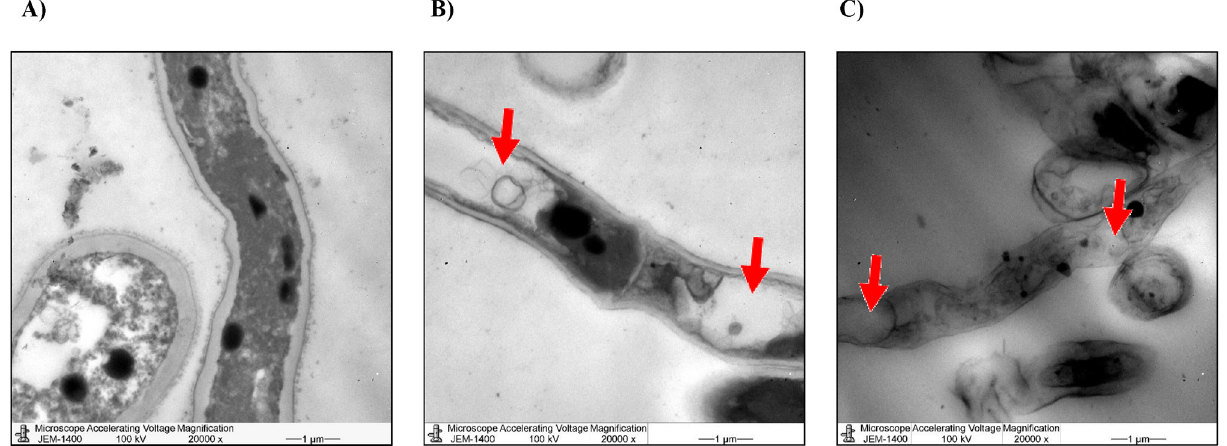
Figure 8. TEM images of the fungal growth of M. phaseolina. The treated fungi showed the accumula- tion of large white vacuoles (red arrows), which caused the rapture of the cellular wall, compared to the control: ( A ) untreated control, ( B ) effect of the water extract of T. aphylla , ( C ) effect of the ethanolic extract of T. aphylla.